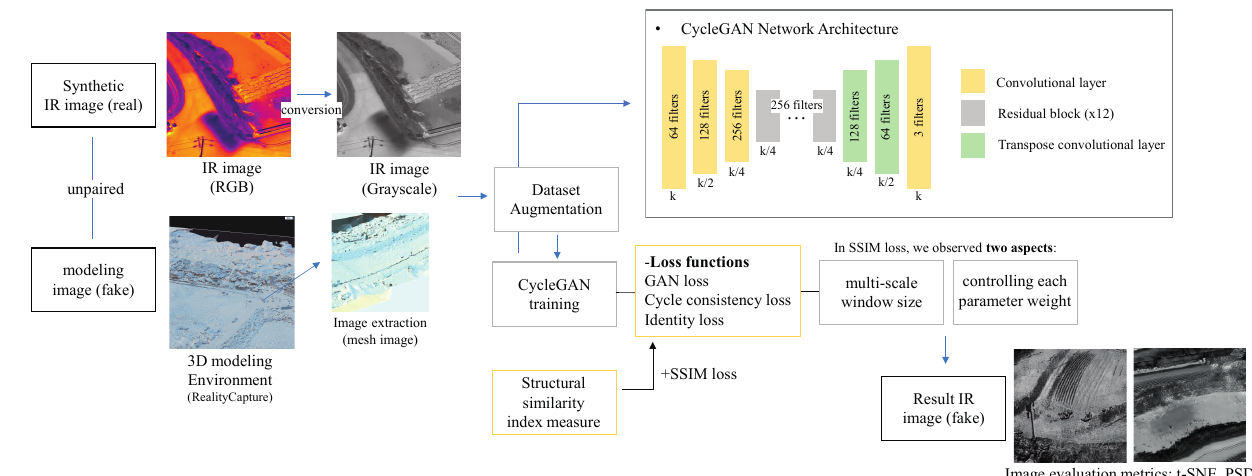
Figure 3. Flowchart to illustrate the methodological steps of the study.